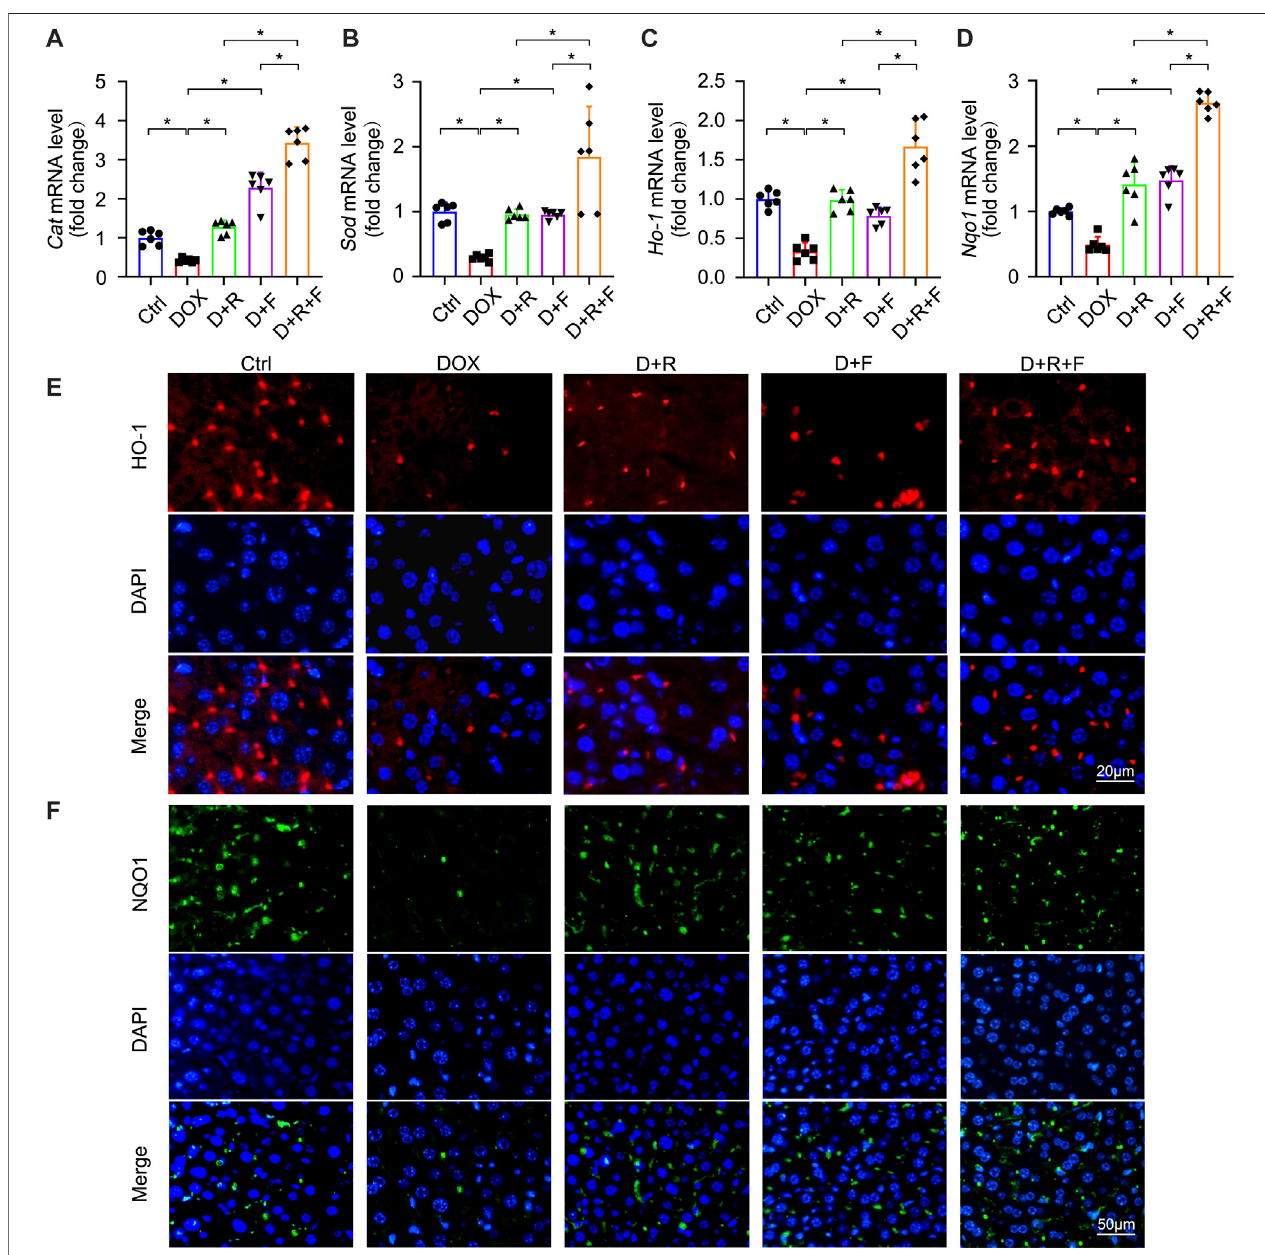
FIGURE 3 | Expression of NRF2 downstream antioxidant factors CAT, SOD, HO-1, and NQO1 was elevated after RES and FGF1 co-treatment in mice. (A-D) Relative mRNA expression levels of Cat , Sod , Ho-1 and Nqo1 after the indicated treatments ( n = 6). (E,F) Representative fl uorescence microscopy images of IF staining for HO-1 (Red) and NQO1 (Green) in liver tissues. Data are expressed as mean ± SD. * p < 0.05.